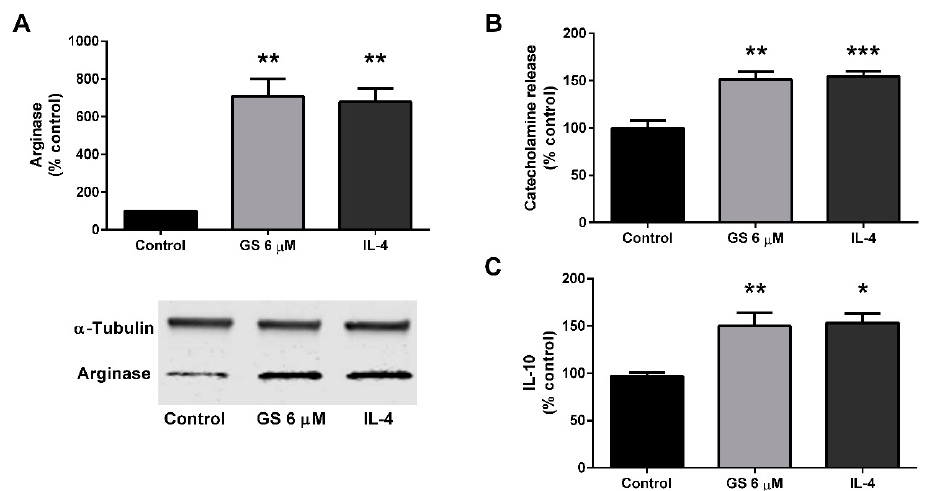
Figure 5. GS treatment in RAW264.7 macrophages induces M2 polarization. GS treatment induces an M2-like phenotype in macrophages as suggested by arginase activation ( A ), catecholamine release into the media ( B ), and release of IL-10 ( C ). Data presented as mean ± SEM from n = 3–6 replicates per group. * p < 0.05, ** p < 0.01, *** p < 0.001. Abbreviations: interleukin 4